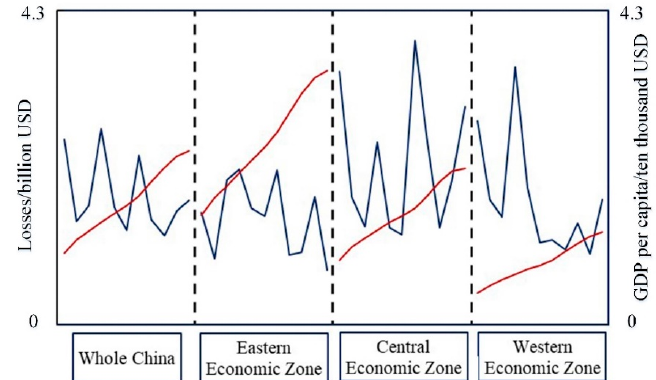
Figure 9. The distributions of natural disaster losses (blue line) and GDP per capita (red line) in each region during the period 2010–2020. region during the period